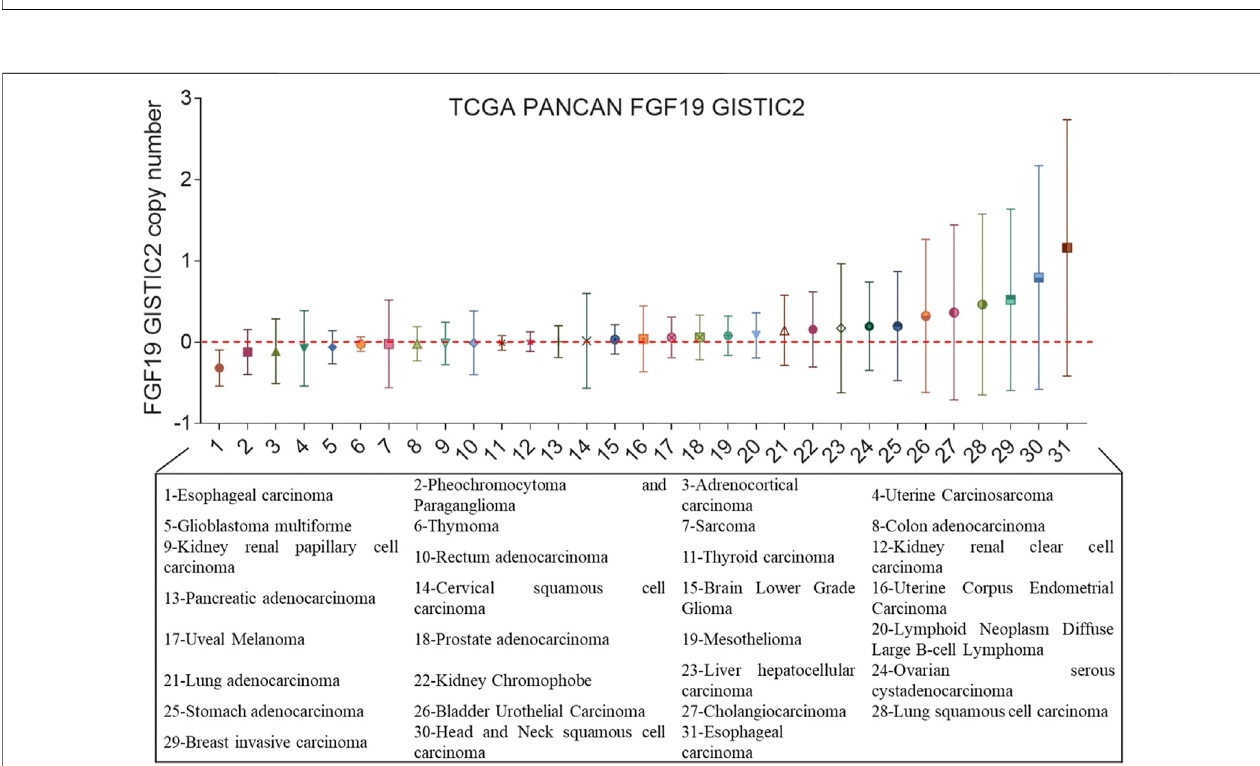
FIGURE4| FGF19genecopynumberincancer.ThegenecopynumberofFGF19indifferentcancertypesfromTheCancerGenomeAtlas(TCGA). Onthe x -axis, there are 31different TCGA tumor types, and on the y -axis, there are the gene copy numbers of FGF19; unit: Gistic2 copy number.